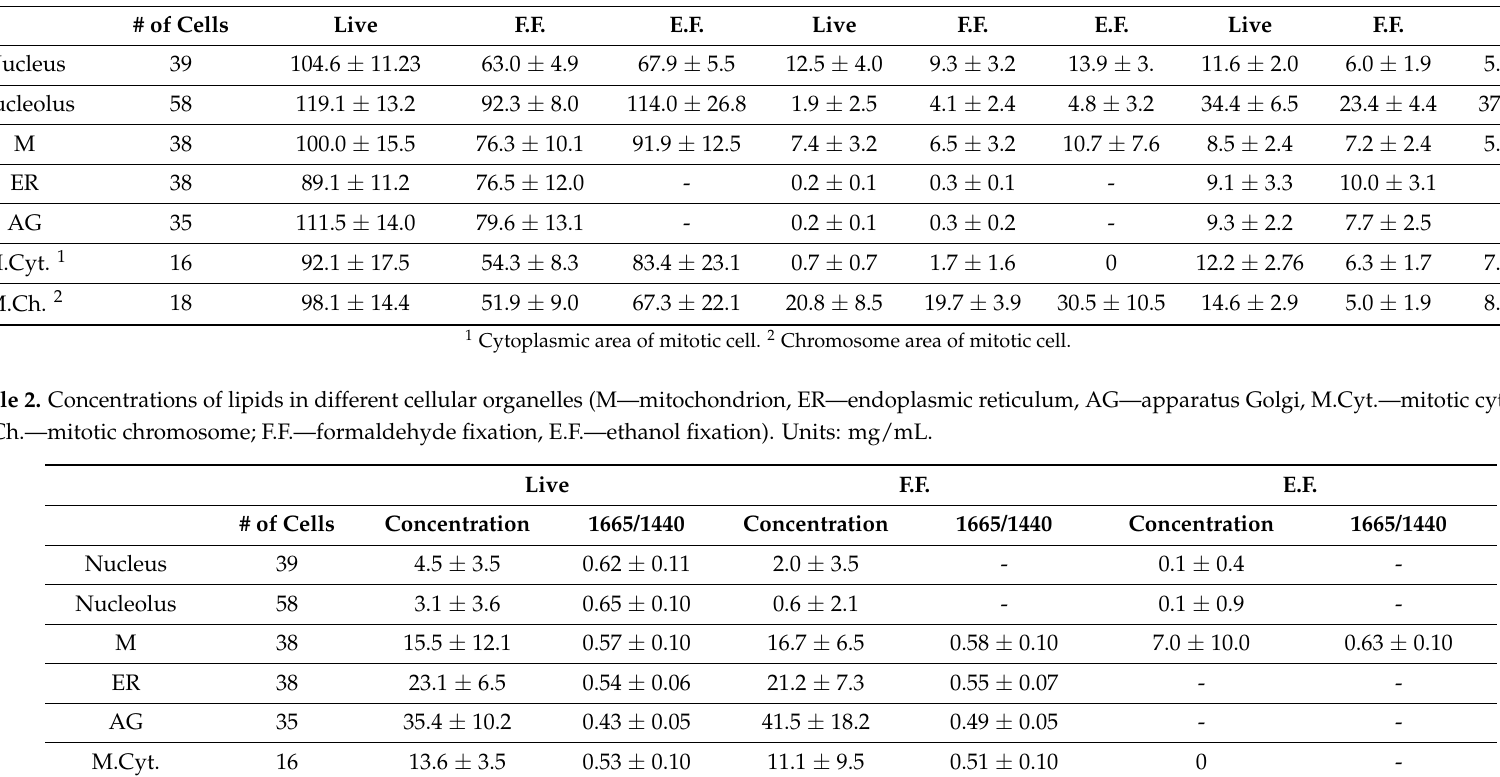
Table 1. Biomolecular concentrations of Proteins, DNA, and RNA in different cellular organelles (M—mitochondrion, ER—endoplasmic reticulum, AG—apparatus Golgi, M.Cyt.—mitotic cytoplasm, M.Ch.—mitotic chromosome; F.F.—formaldehyde fixation, E.F.—ethanol fixation). Units: mg/mL. Proteins DNA RNA Live F.F. E.F. F.F. E.F. F.F.